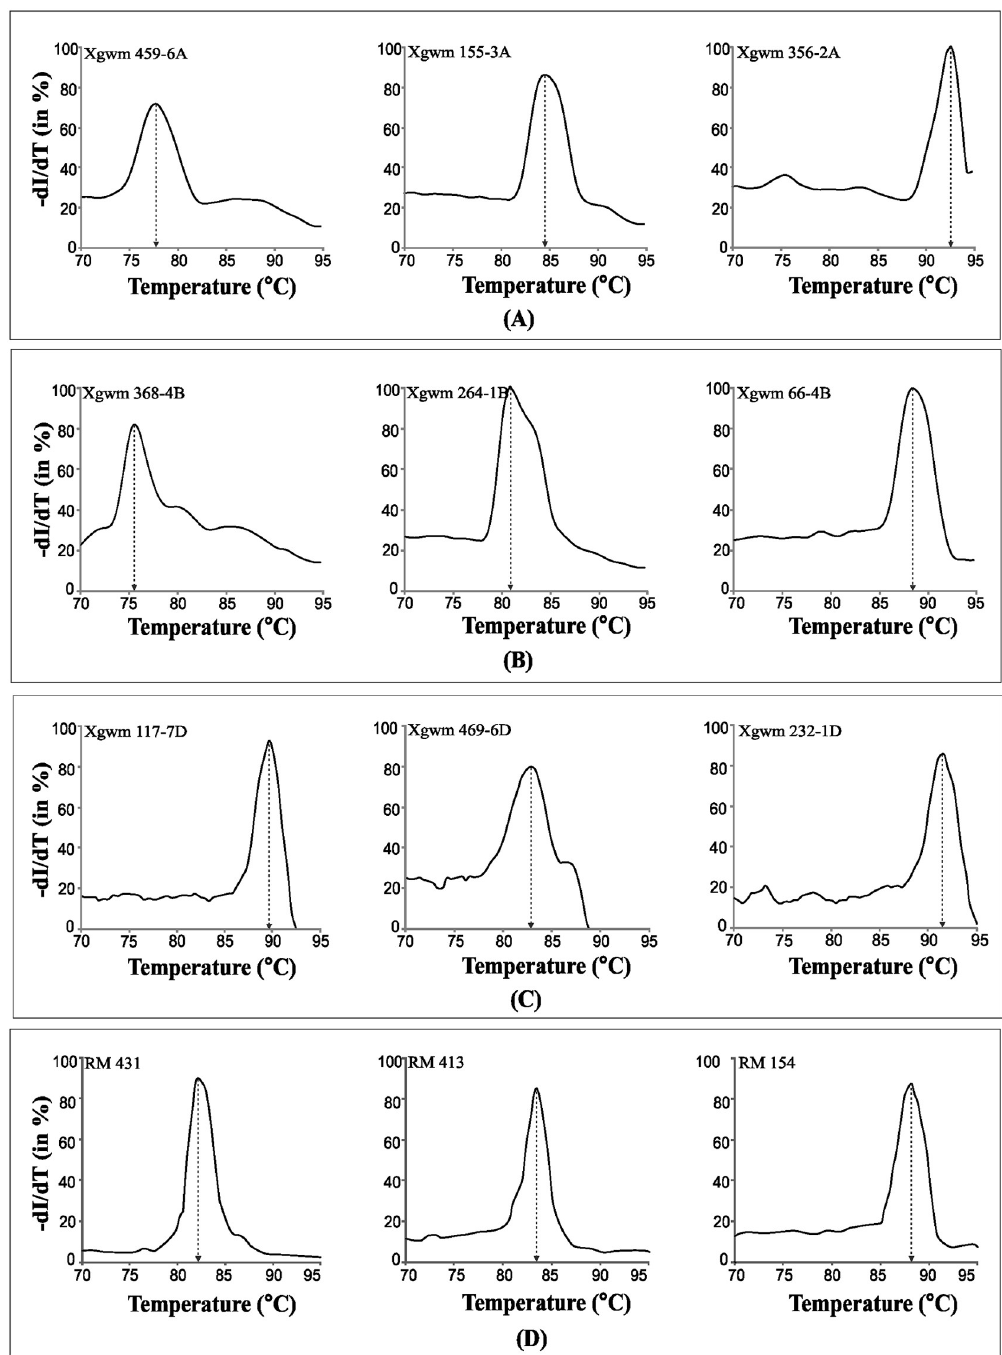
Fig 2. SYBR Green melt-profiles specific to different STMS markers. A) melt-profiles of three STMS markers specific to wheat A-genome, B) melt-profiles of three STMS markers specific to wheat B-genome, C) melt-profiles of three STMS markers specific to wheat D-genome, and D) melt-profiles of three rice STMS markers. The STMS markers were amplified using a representative genotype. Designation of STMS is indicated on upper left corner of each plot and the Tm is indicated by vertical dashed